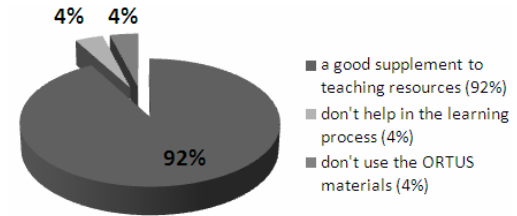
Figure 9. Students’ views on the use of ORTUS material in learning process at Riga Technical